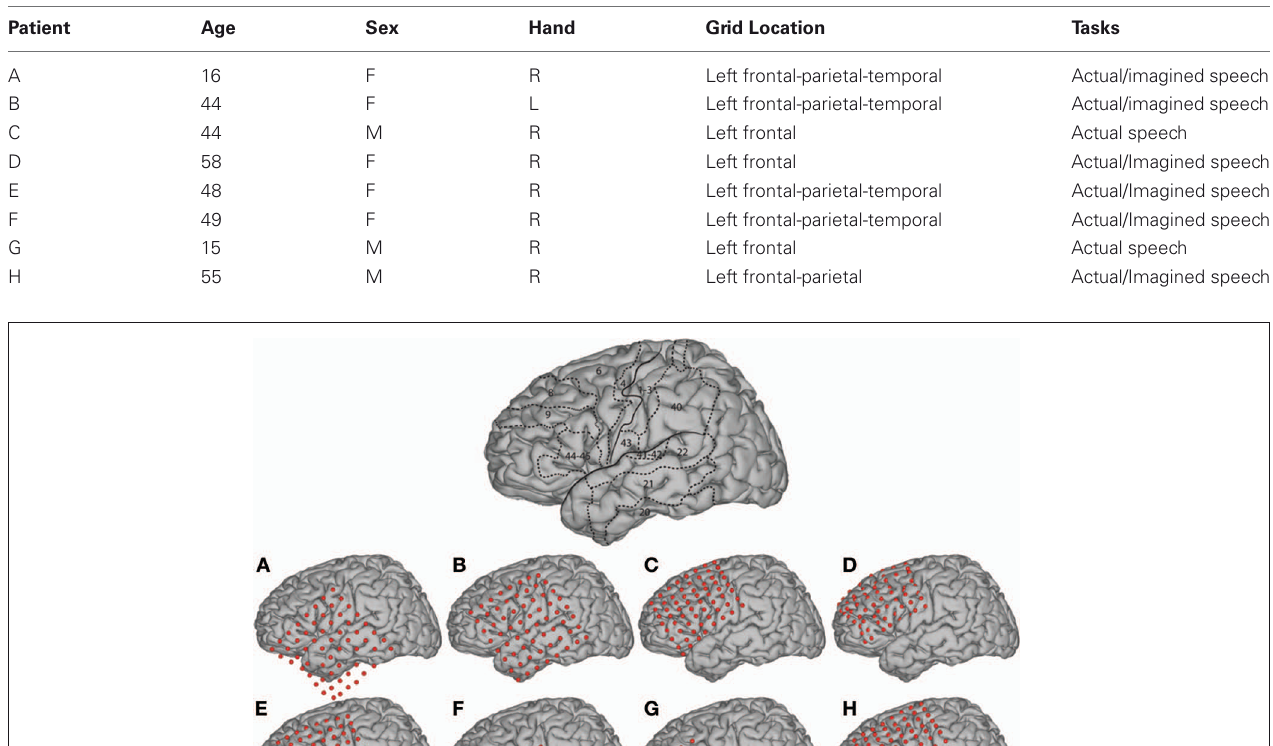
EXPERIMENTAL PARADIGM